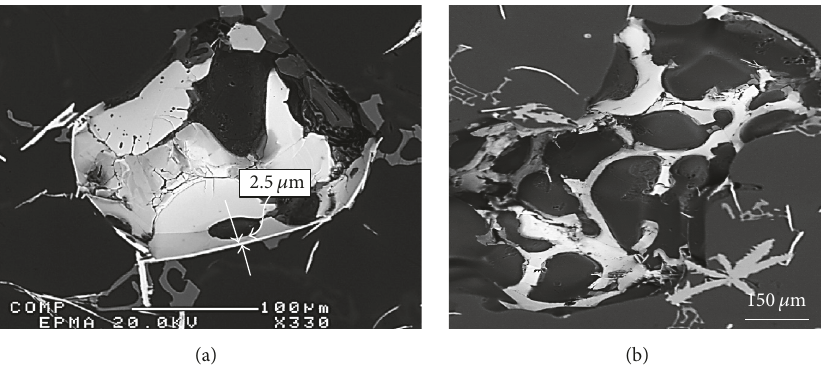
Figure 10: Backscattered electron images of (a) the white phase in Figure 8(a) revealing its plate-like shape, and (b) the grey sludge phase in Figure 8(b). The two straight arrows pointing towards each other in (a) simply highlight the thickness of the platelet-like phase and the curved arrow that links the label 2.5 𝜇 m to the platelet indicates the actual thickness.